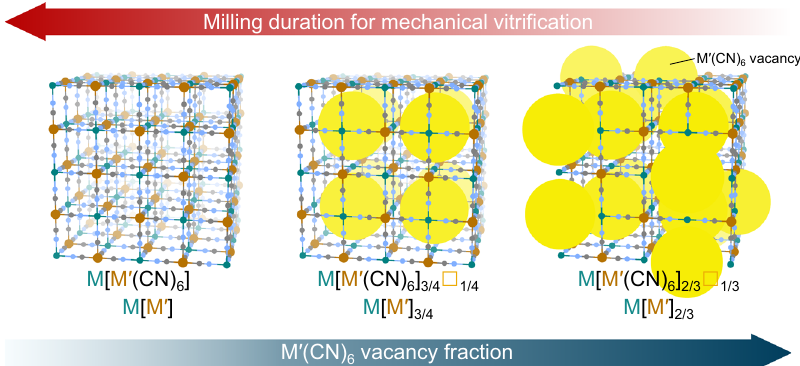
Fig. 1 Schematic diagram of the correlation between milling duration for mechanical crystal – glass transformation and vacancy fractions in PBAs with M and M' cations. Green, brown, grey, and blue spheres represent M, M ’ , C, and N, respectively. H and O atoms are omitted. Yellow spheres represent M'(CN) 6